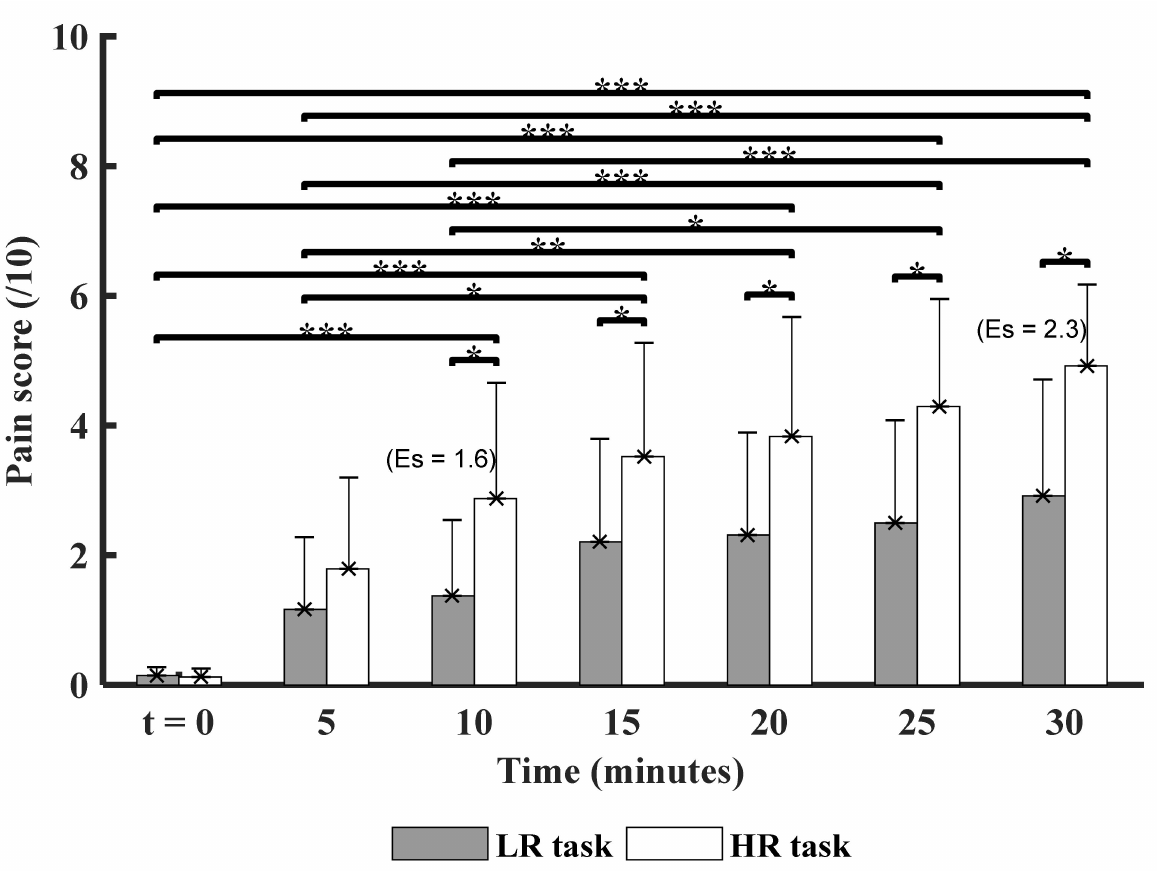
Figure 3. Comparison of mean pain score between both experimental task conditions (LR: Low Risk and HR: High risk) across the 30-min time (t 0 : baseline measure, before starting each task, t 5 , t 10 , t 15 , t 20 , t 25 , and t 30 : at the end of tasks). Significant differences are marked with asterisk: (* p < 0.05, ** p < 0.01, and *** p < 0.001). ES = effect size of conditions on pain